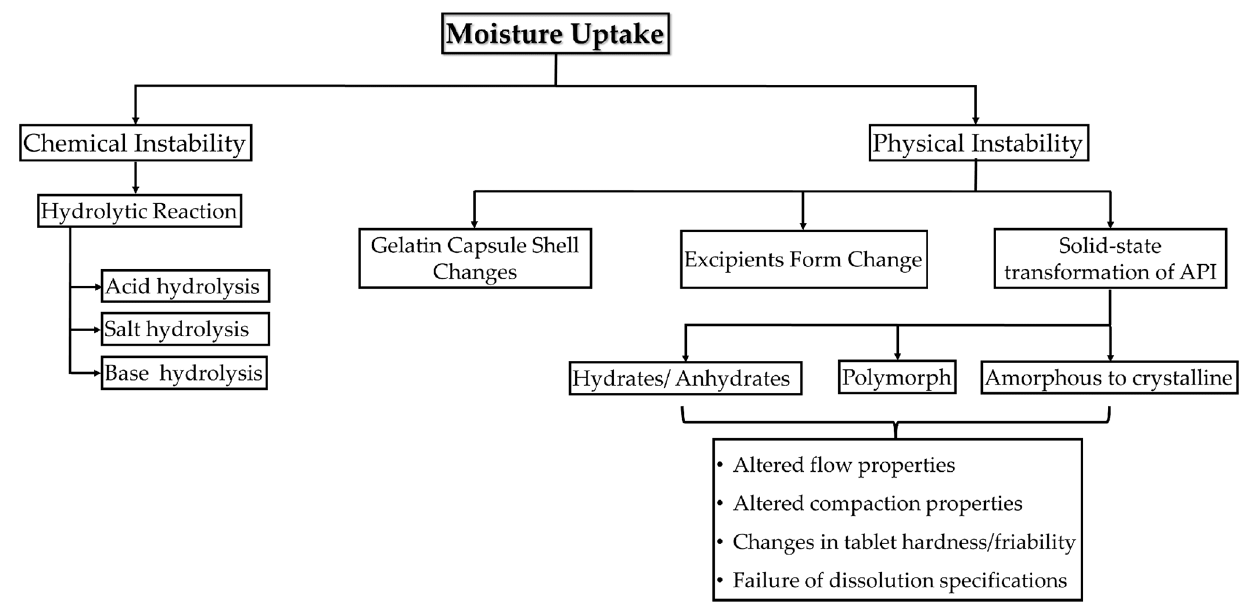
Figure 5. Schematic chart showing the chemical and physical instabilities caused due to moisture ingress in an API. ingress in an